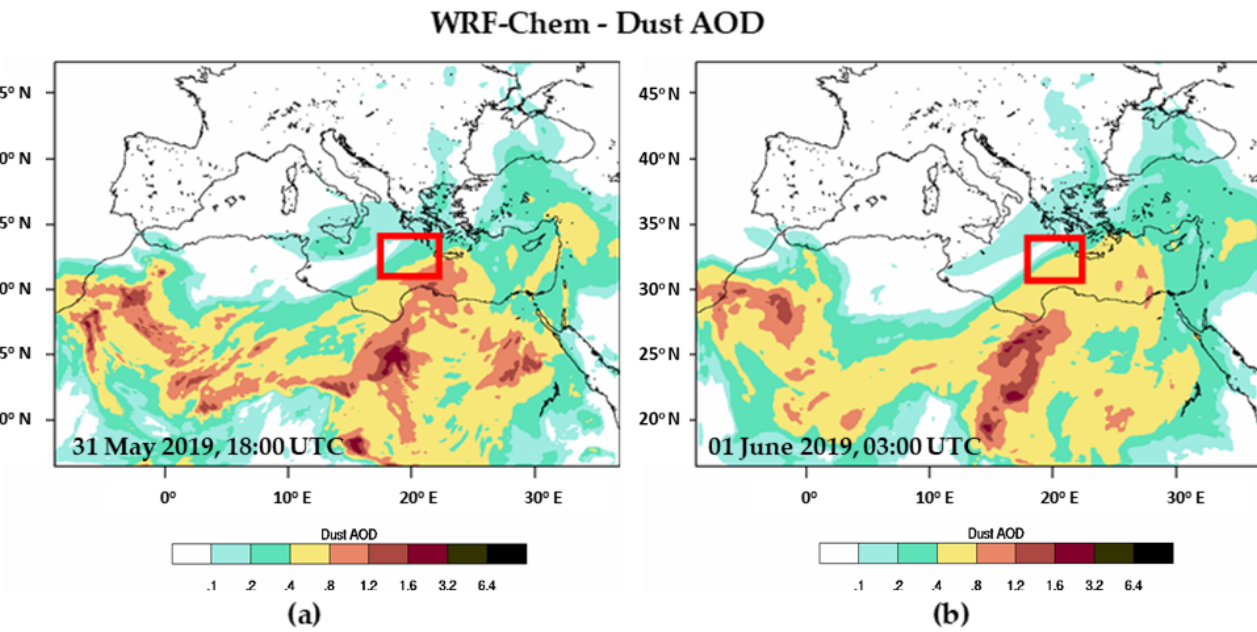
Figure A2. ( a ) Modeled dust AOD (in µ g/m 3 ) on 31 May 2019 18:00 UTC and ( b ) on 1 June 2019, 03:00 UTC. The location of the possible dust-prone areas above Mediterranean Sea is marked with a red square.